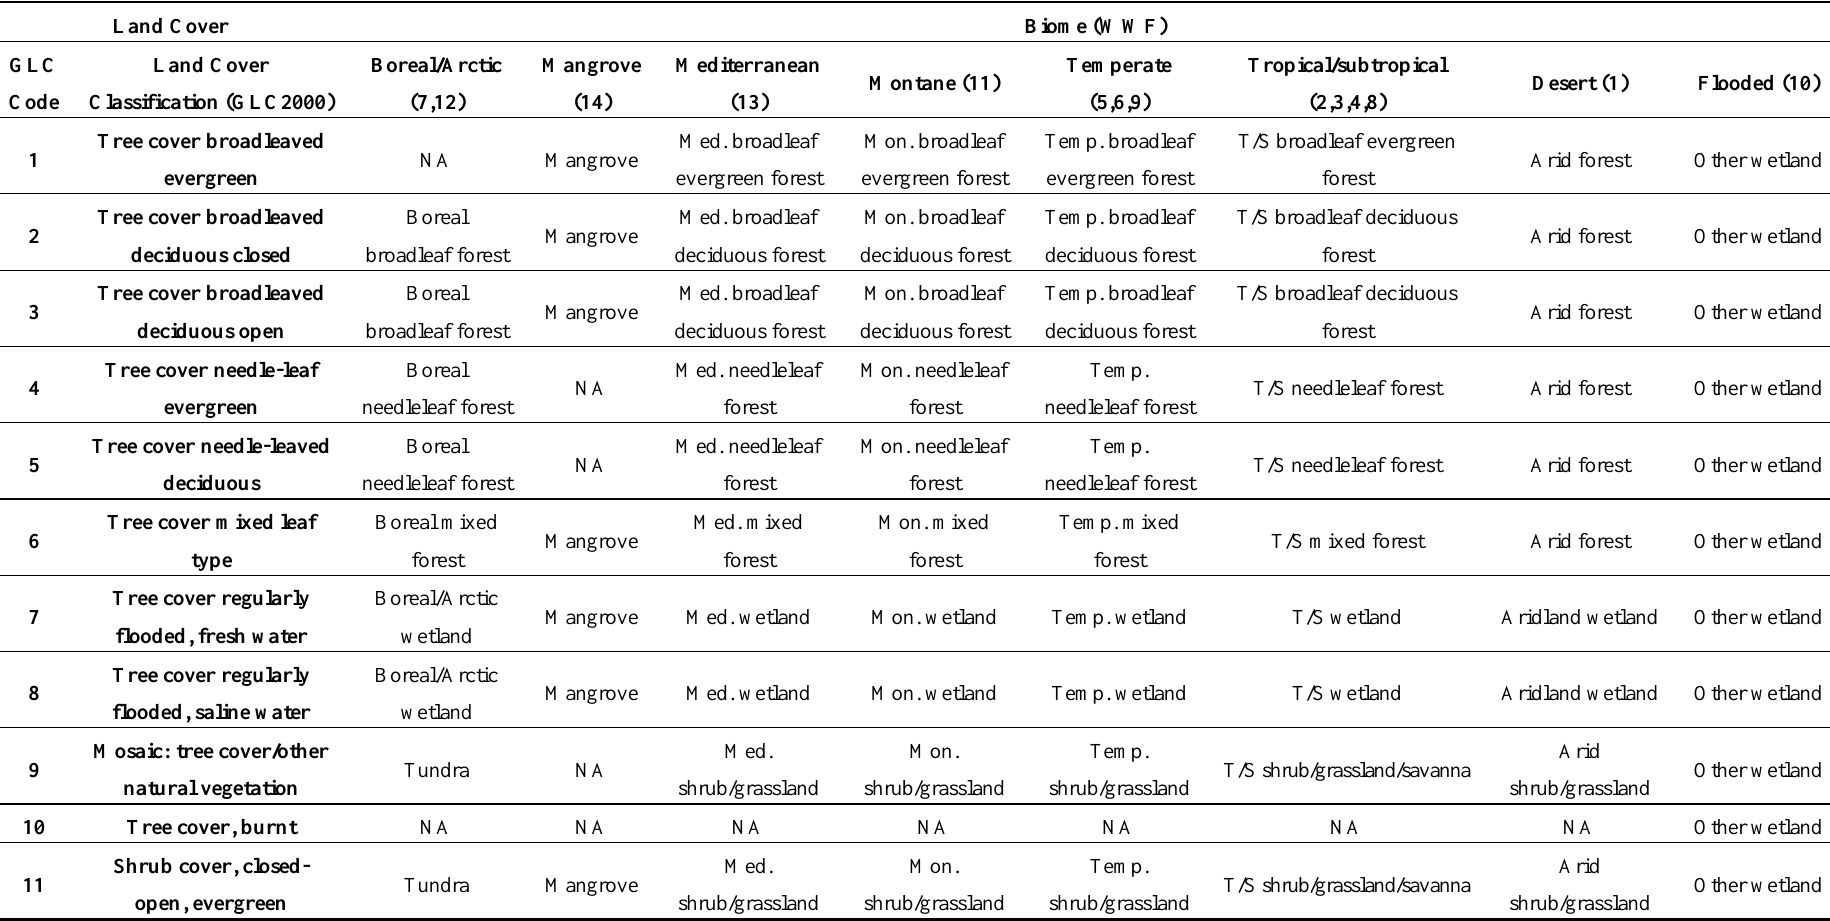
Table 2. Classification of ecosystem type from World Wildlife Fund (WWF) biome and Global Land Cover 2000 (GLC2000) land cover type. Columns represent WWF biomes and rows represent GLC2000 land cover within the biome; text within the table represents ecosystem type used in this study. Abbreviations: Med. = Mediterranean, Mon. = Montane, Temp. = Temperate, T/S = Tropical/subtropical. NA = not